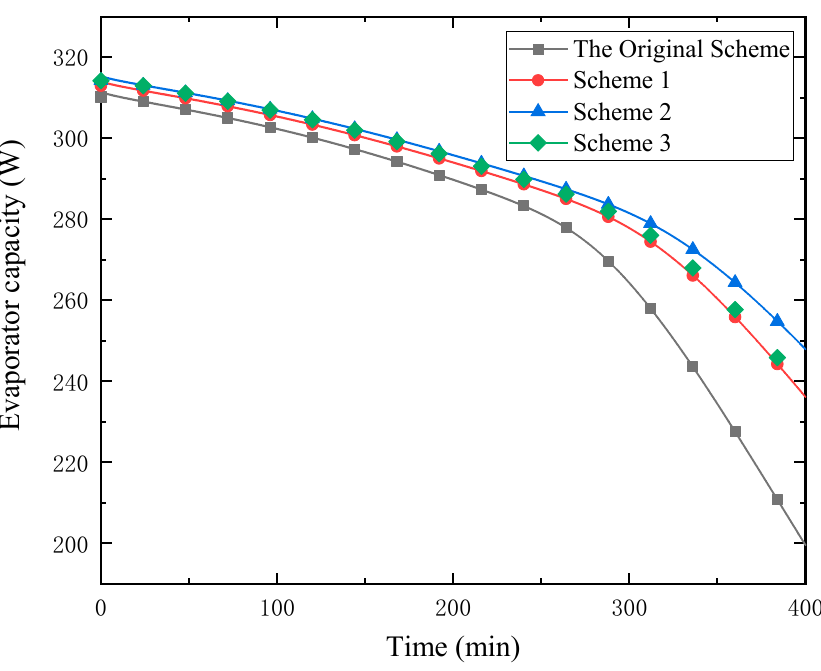
Figure 6. Evaporator capacity for three schemes during 400 min frosting duration.